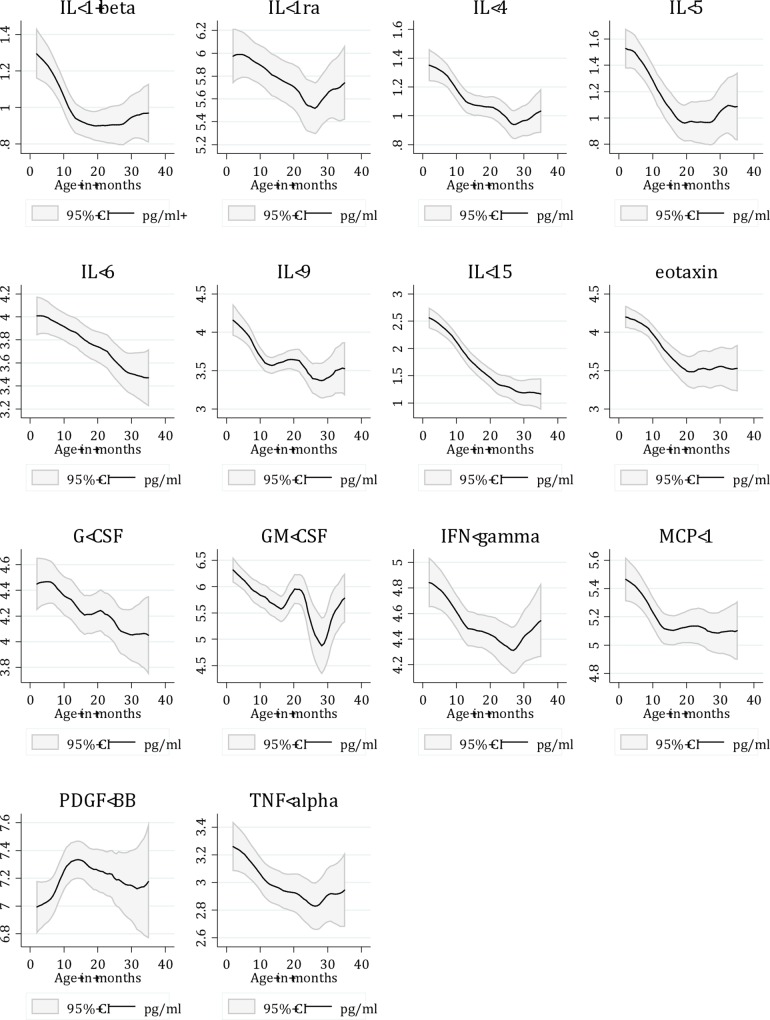
Cytokine concentrations in relation to age in a sample of Nepalese children with WHO defined severe or non-severe pneumonia.Cytokine concentrations are shown as natural log-values. Only cytokines with significant differences are shown.